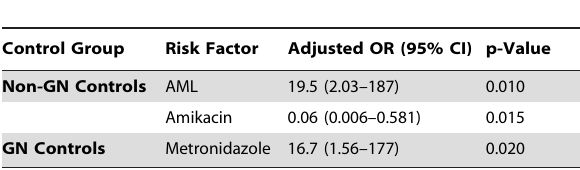
Table 4. Multivariate analysis of risk factors associated with multi-resistant Pseudomonas aeruginosa bloodstream infections among patients admitted to the haematology intensive care unit of a tertiary academic hospital, in Cape Town, South Africa, January 2010–January